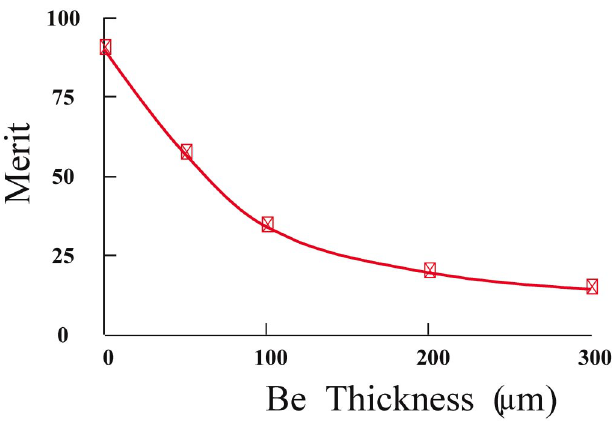
FIG. 18. (Color) Dependence of M factor on rf window